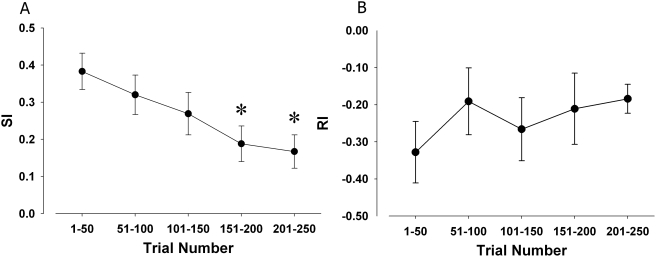
Mouse vigilance decrement in the 5C-CPT over time.The performances of C57BL/6J and DBA/2J mice over time in the 5C-CPT were compared. Performance was binned into 50 trial blocks to ensure consistency in trial number across blocks so that proportional data could be compared. No strain by trial block interaction was observed for any measure. A significant main effect of trial block was observed for SI (A) however, indicative of poorer vigilance with cognitive fatigue. No effect of trial block was observed for responsivity index RI (B), indicating that the deterioration of cognitive performance over time was not confounded by physical factors, consistent with human CPT performance. Data presented as mean+s.e.m., and * denotes p<0.05 when compared to trial block 1.